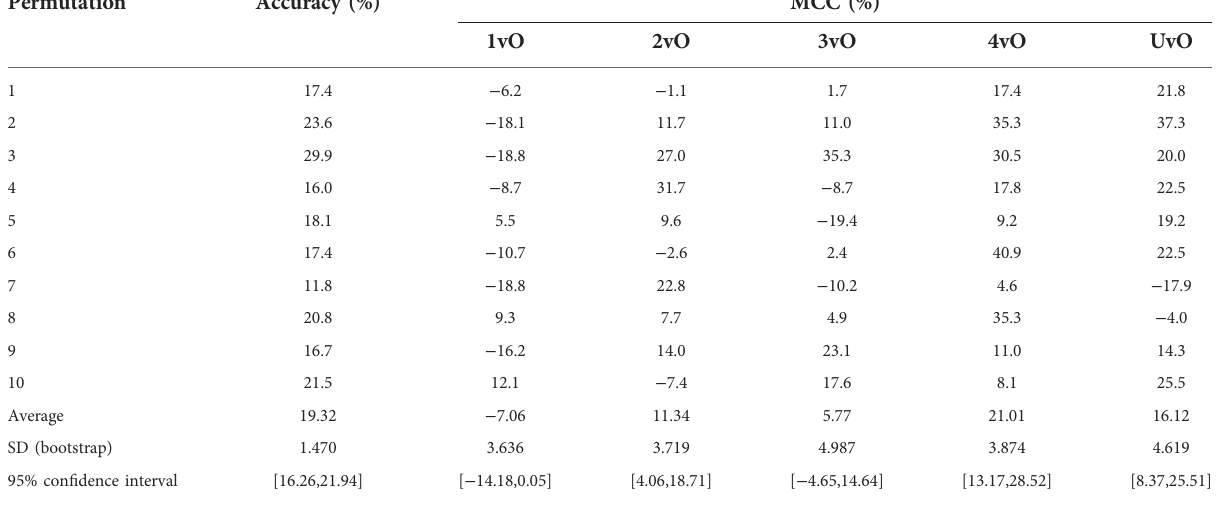
TABLE 3 Accuracy and Matthews correlation coef fi cient (MCC) of validation set of random label shuf fl ing of training set of 1,278 pressure ulcer images, repeated ten times.